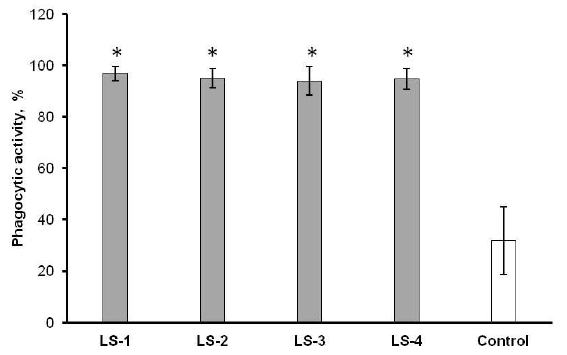
Figure 10. Effects of S. deserta Schang. (LS-1, LS-2) and S. sclarea L. (LS-3, LS-4) extracts on the phagocytic activity of peritoneal macrophages. (LS-1, LS-3) sage extracts obtained by conventional extraction and (LS-2, LS-4) sage extracts obtained by ultrasonic-assisted extraction. (*) indicates significant differences in comparison to control, p < 0.05.